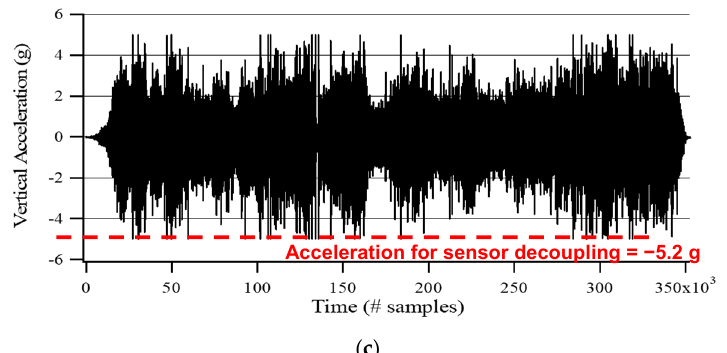
Figure 3. Vertical acceleration of the new generation sensor (Sensor #1) at different test speeds collected along asphalt pavement with no RDD dynamic load. ( a ) 1.6 km/h (1 mph); ( b ) 4.8 km/h (3 mph); ( c ) 8.0 km/h (5 mph).